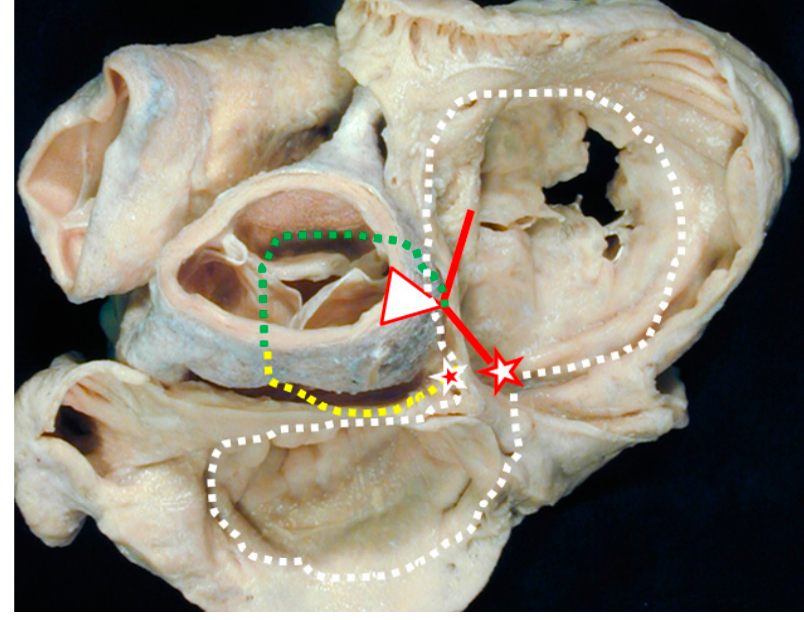
Figure 1. Cardiac base as seen from the atrial aspect. White star, red borders: the atrioventricular node; Red line: the bundle of His; Green dotted line: the dead-end tract (the continuation of the atrioventricular conduction axis); Yellow dotted line: the retro-aortic ring branch; White dotted line: embryonic atrioventricular ring; Red star, white borders: the retroaortic node; This image was both provided and labelled by Professor Robert H. Anderson and reproduced with his kind